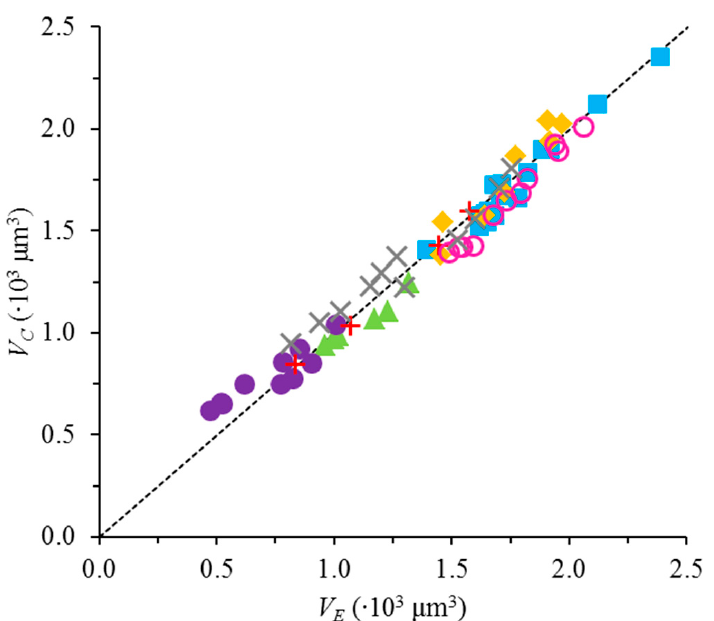
Figure 10. Parity plot of experimentally determined volume of droplets formed in: water ( ■ ), 9% ethanol ( ▲ ), 28% ethanol ( ● ), 20% glycerol ( ♦ ), 30% glycerol (+), 20% sucrose ( ○ ) and 25% sucrose (X) and values predicted using Equation (9). The dashed line represents the line of parity; [73], Copyright Elsevier). Properties of the liquids are shown in Table 4. Reprinted with permission from Elsevier. Table 4. Viscosity and interfacial tension with hexadecane at 20 °C.